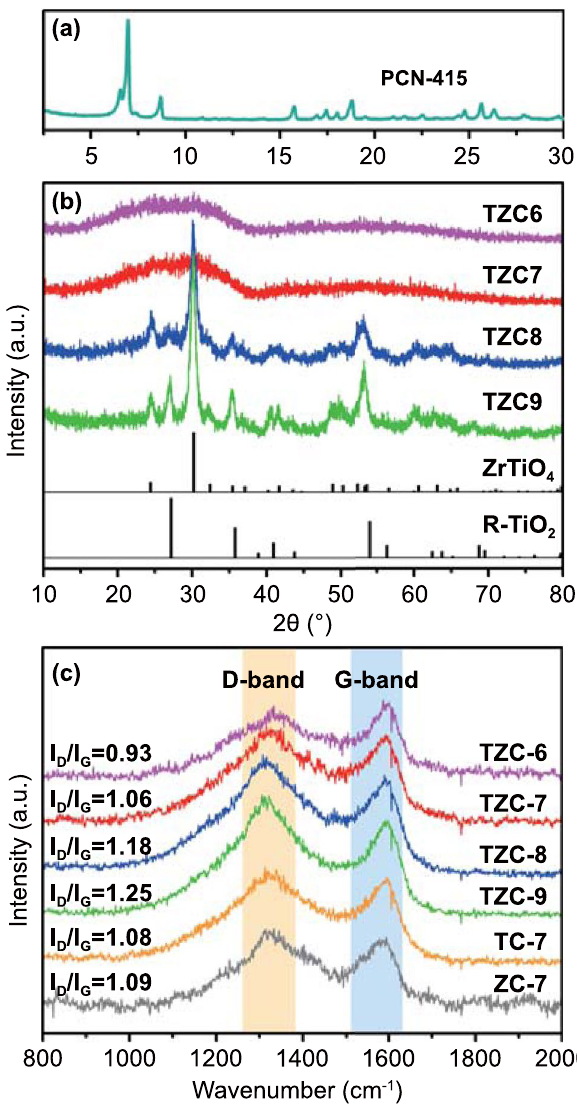
Fig. 2 a PXRD patterns of PCN-415 and b PCN-415 derivatives. c Raman spectra of all MOF